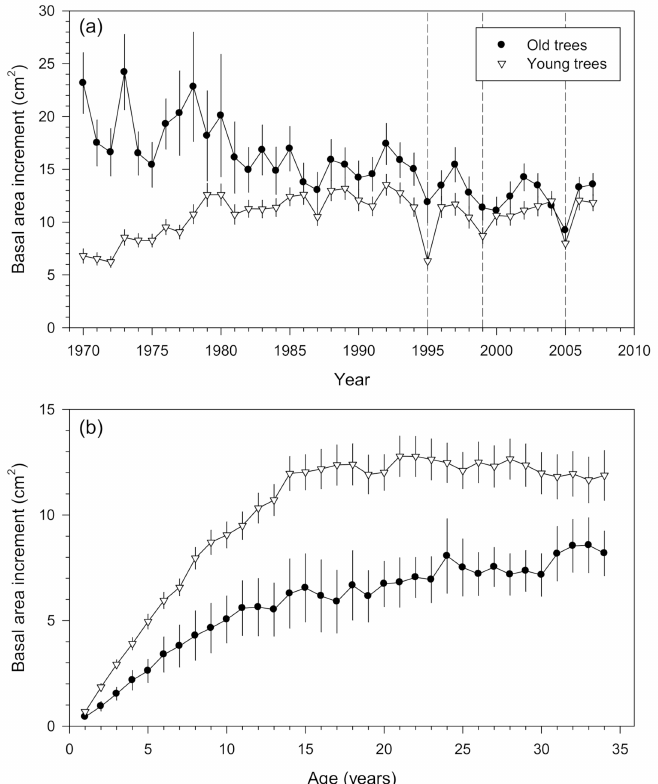
Figure 2. Basal area increments of old and young trees as a function of the calendar year ( a ) and cambial age ( b ). The vertical dashed lines in plot ( a ) correspond to the 1995, 1999 and 2005 droughts (see Figure S1 in the Supplementary Materials). Values are means ±